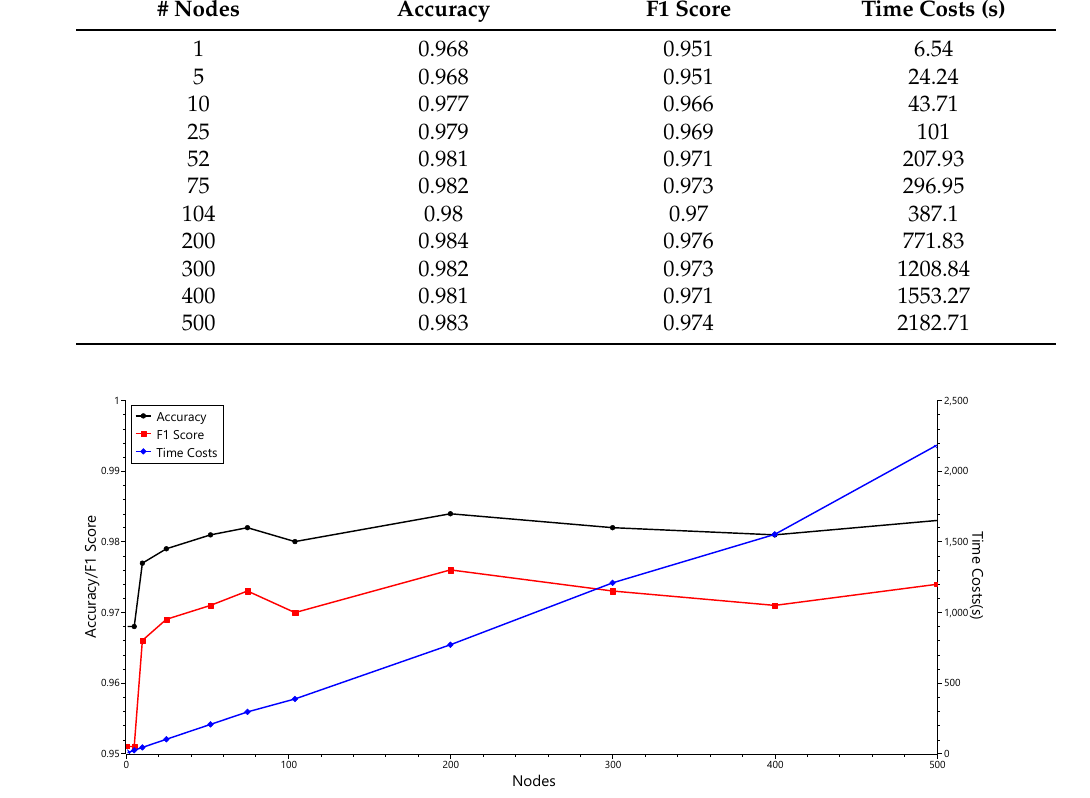
Figure 7. Schematization of a hyperparameter optimization result for a single hidden